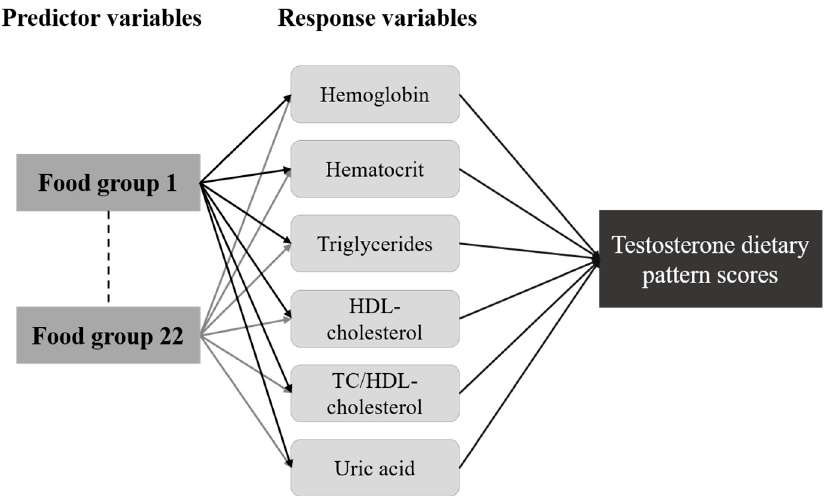
Figure 1. Schematic diagram of reduced rank regression conceptual framework. HDL-cholesterol, high-density lipoprotein cholesterol; TC/HDL-cholesterol, total cholesterol to HDL-cholesterol ratio.